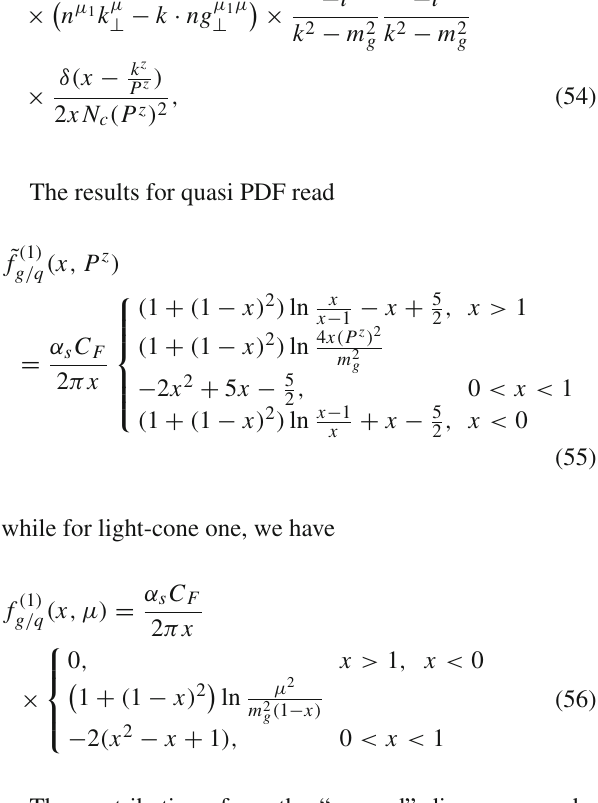
Figure 3c gives